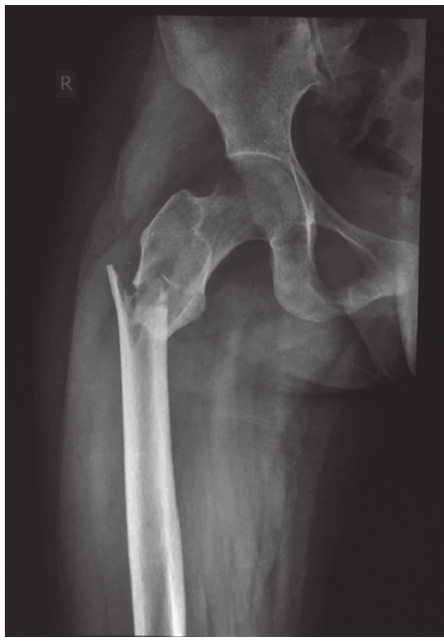
Figure 1: X-ray showing the right subtrochanteric fracture. Table 1: Summary of